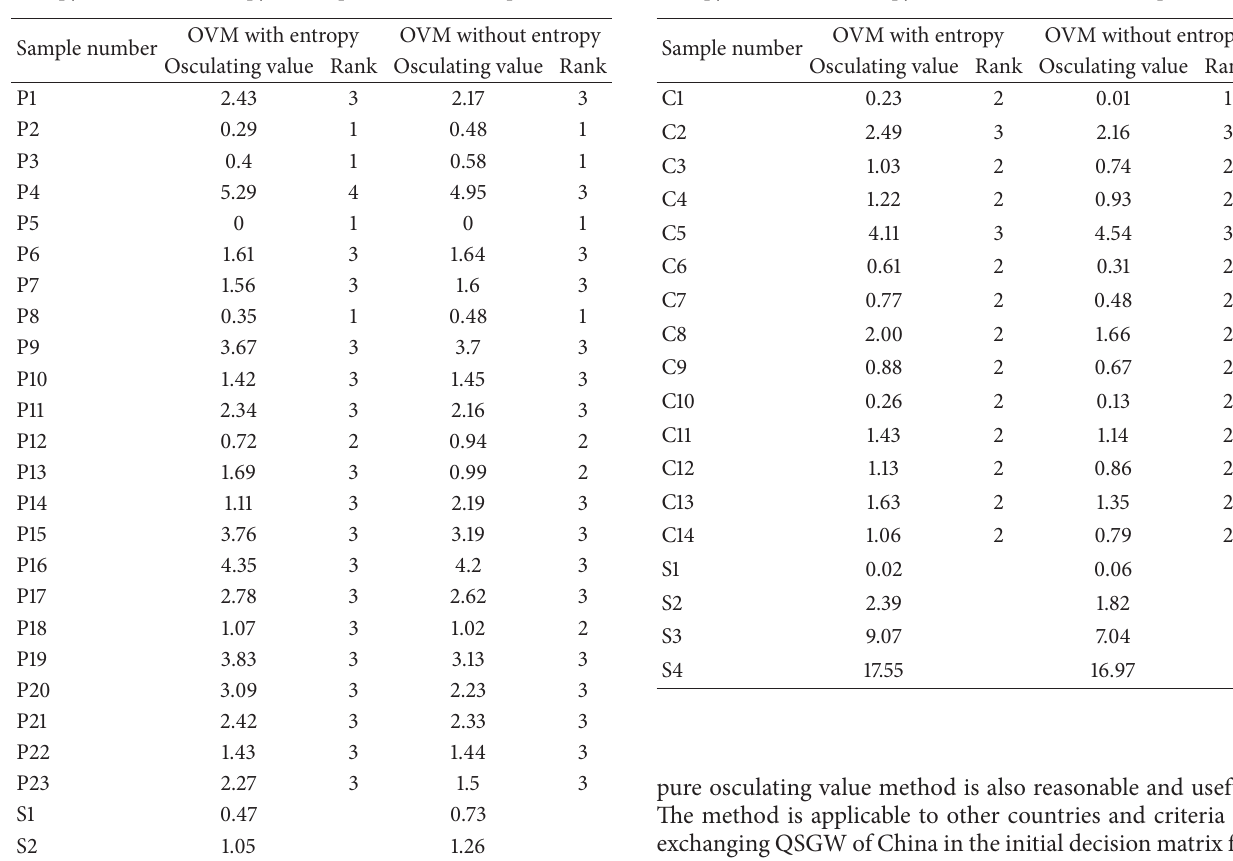
Table 2: Assessment results of osculating values method with entropy and without entropy for the phreatic water samples.